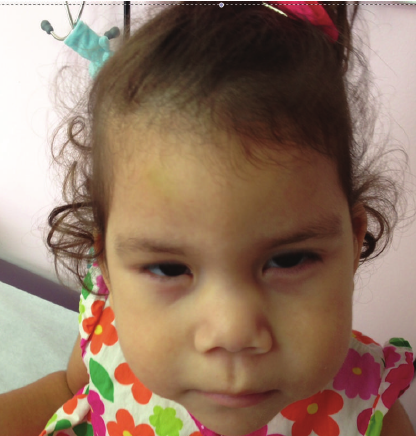
Figure 1: Face: note microcephaly; metopic ridge; wide, depressed nasal bridge; long philtrum; full cheeks; and retrognathia.